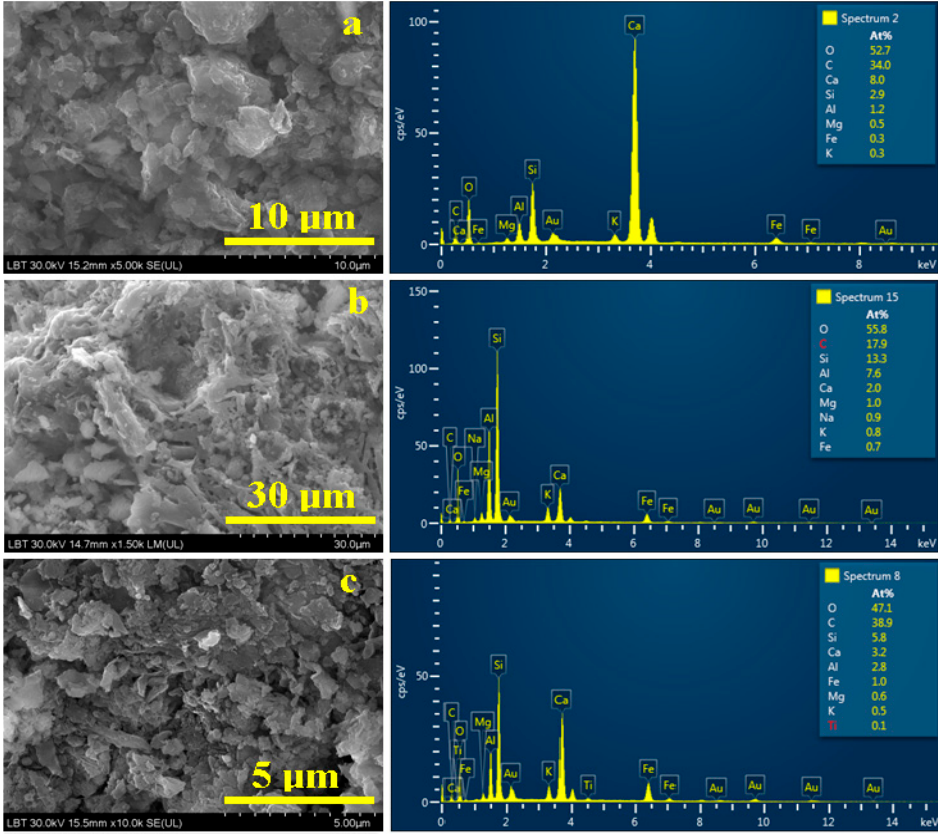
Figure 7. SEM images and EDS spectra obtained for the mineral fractions within the amphora sediments: ( a ) Sample1, ( b ) Sample 2 and ( c ) Sample 3.